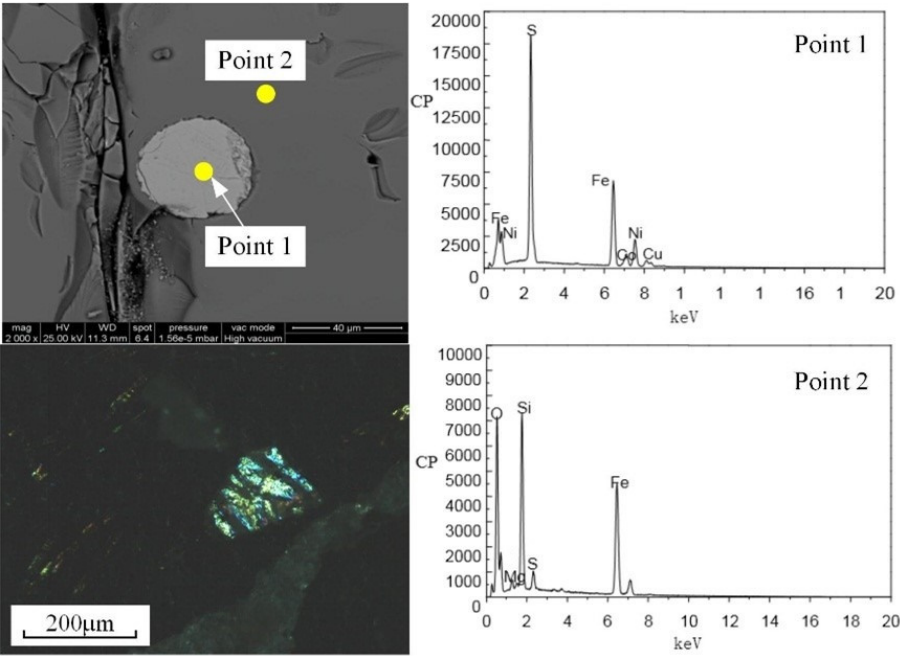
Figure 1. Microstructure of ferronickel